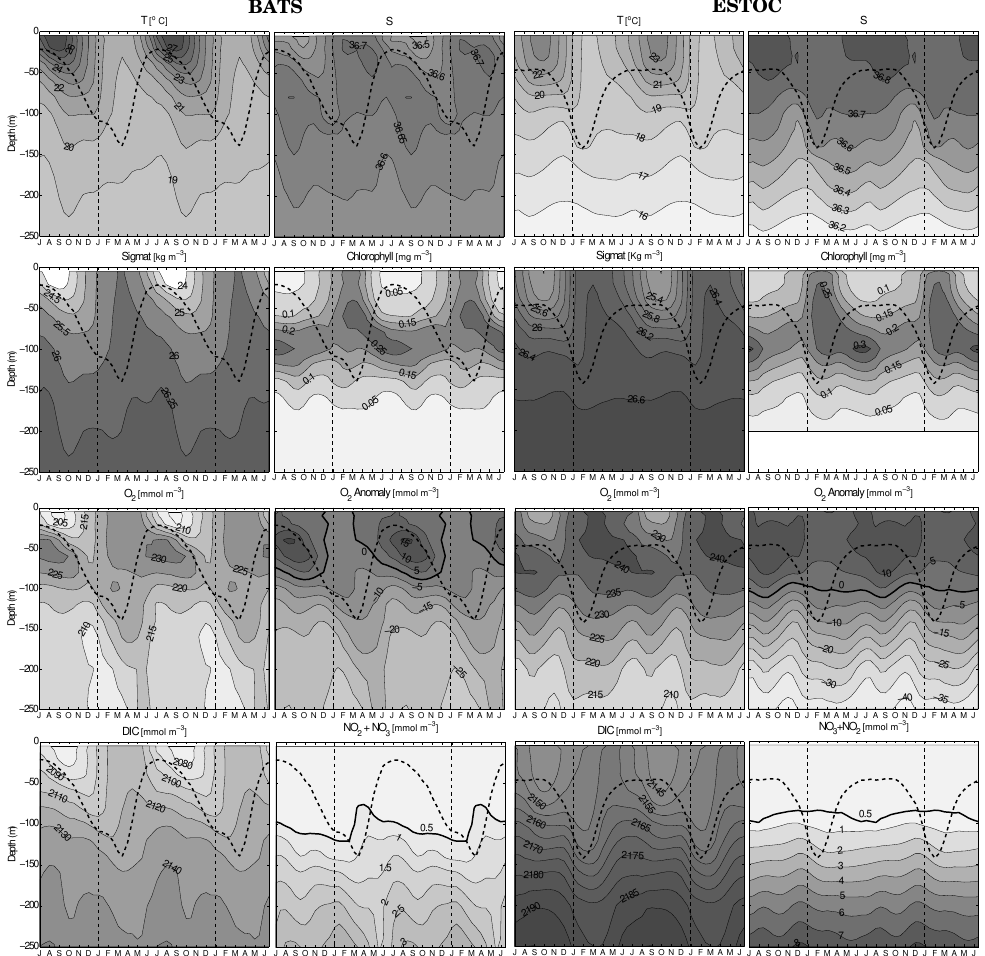
Fig. 1. Seasonal cycles of the vertical distribution of temperature ( ◦ C), salinity (psu), density anomaly σ T (kgm − 3 ), chlorophyll a (mg m − 3 ), nitrate + nitrite (mmolm − 3 ), oxygen (mmolm − 3 ), oxygen anomaly (mmolm − 3 ) and dissolved inorganic carbon (DIC) (mmolm − 3 ). Black discontinuous line represents the mixed layer depth. Black thick line represents the isoline of zero oxygen anomaly and the nitracline ([NO 3 ] = 0 . 5mmolm − 3